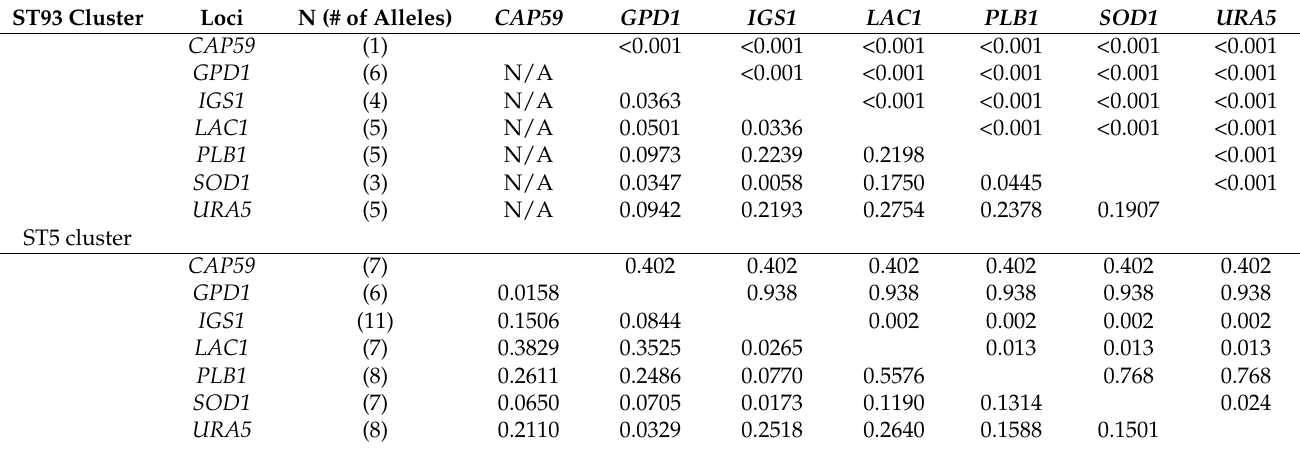
Table 9. Linkage disequilibria between pairs of loci in two sequence type clusters of C. neoformans